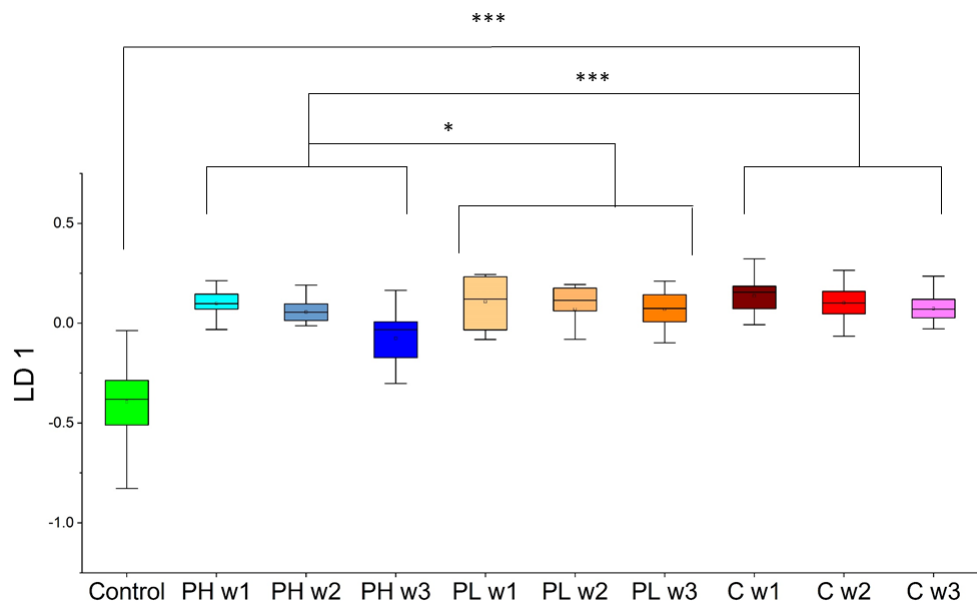
Figure 6. One-dimensional LDA plot where the model was trained to classify control from cancer week 3 and tested on cancer weeks 1-2, pita high and pita low samples (PH = pitavastatin high, PL = pitavastatin low, C = cancer). * p -value < 0.05, *** p -value <